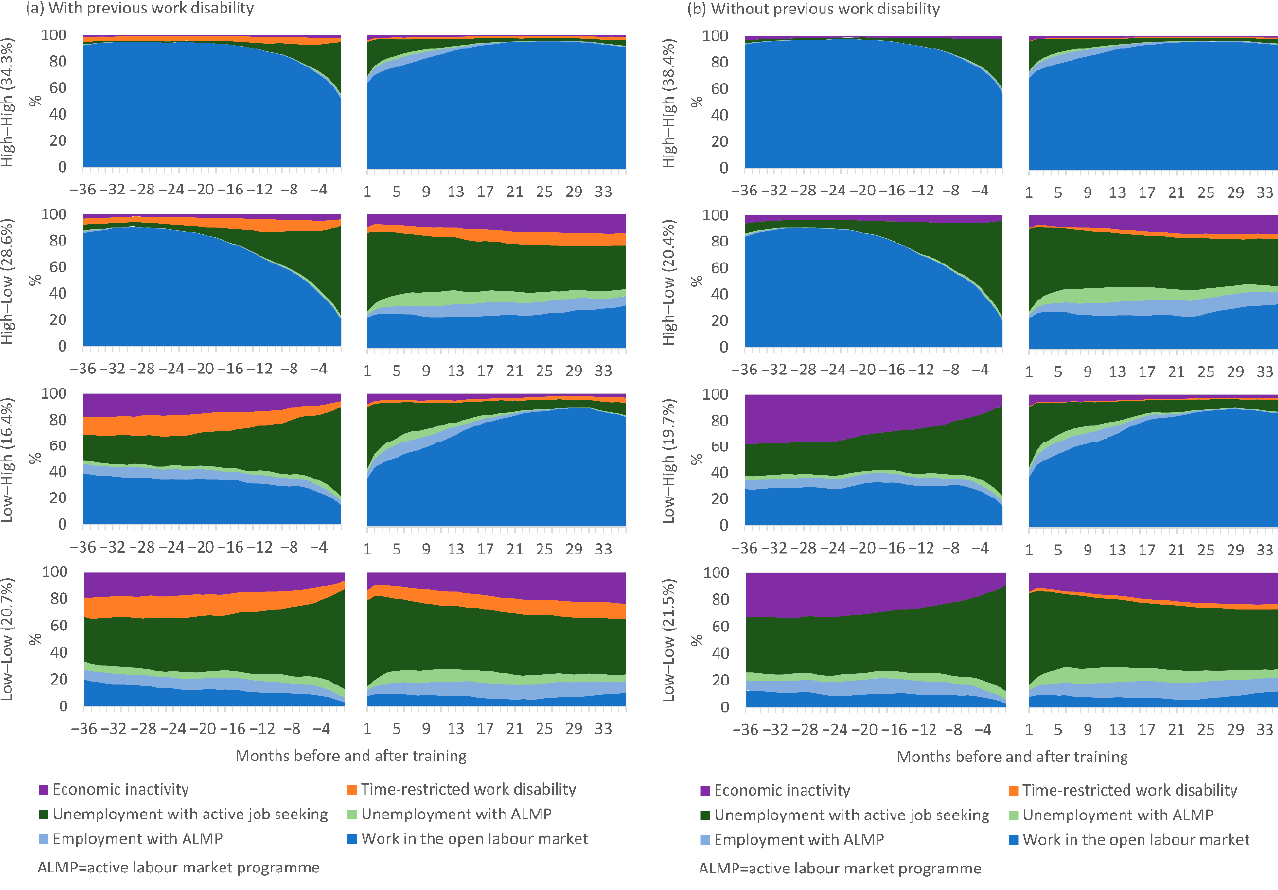
Figure 2. Monthly percentage of time spent in different labour market statuses before and after vocational labour market training amongst the different trajectory groups of work participation in the open labour market, separately for those ( a ) with ( n = 12,697) and ( b ) without ( n = 29,994) previous work disability. Table 2. Percentage distributions within the trajectory groups of work participation in the open labour market before and after vocational labour market training and relative risk ratios (RRR) and 95% confidence intervals (CI) for being assigned to the trajectory groups by previous work disability status.